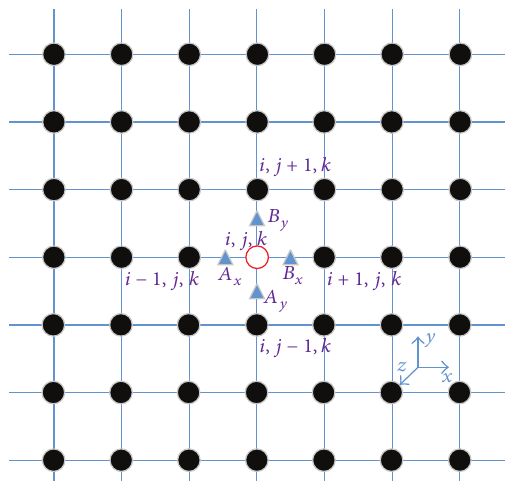
Figure 1: Illustration of the discretization scheme in the 𝑥 - 𝑦 plane.